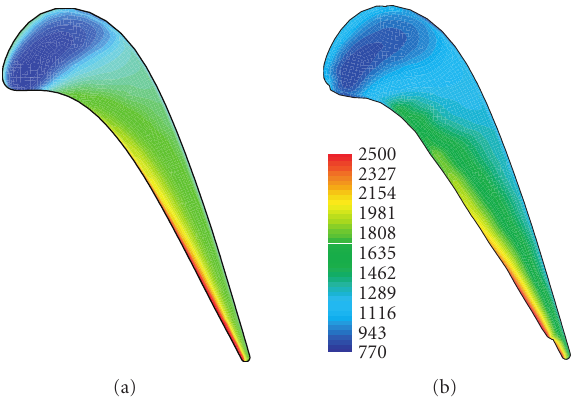
Figure 7: Contours of heat transfer coe ffi cient (W/m 2 -K) on blade tip, (a) baseline flat tip and (b) desensitized flat